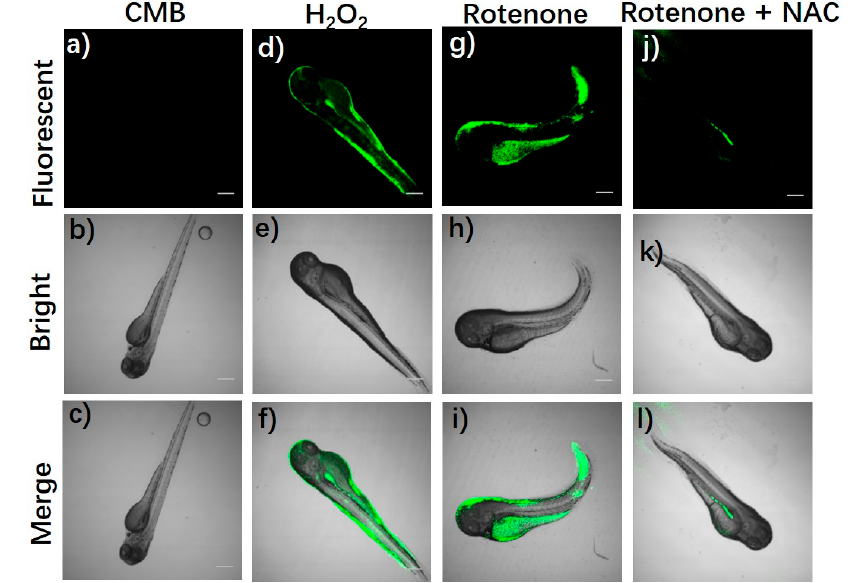
Figure 7. Confocal images for exogenous and endogenous H 2 O 2 in zebrafish. ( a – c ) Zebrafish were stained with CMB (2 μ M). ( d – f ) Zebrafish were incubated with H 2 O 2 and then stained with CMB (2 μ M). ( g – i ) Zebrafish were incubated with rotenone and then stained with CMB (2 μ M). ( j – l ) Zebrafish were incubated with rotenone, treated with NAC, and then stained with CMB (2 μ M). The excitation wavelength was 405 nm and the emission was collected at 420 to 520 nm. Scale bar = 300 μ m.